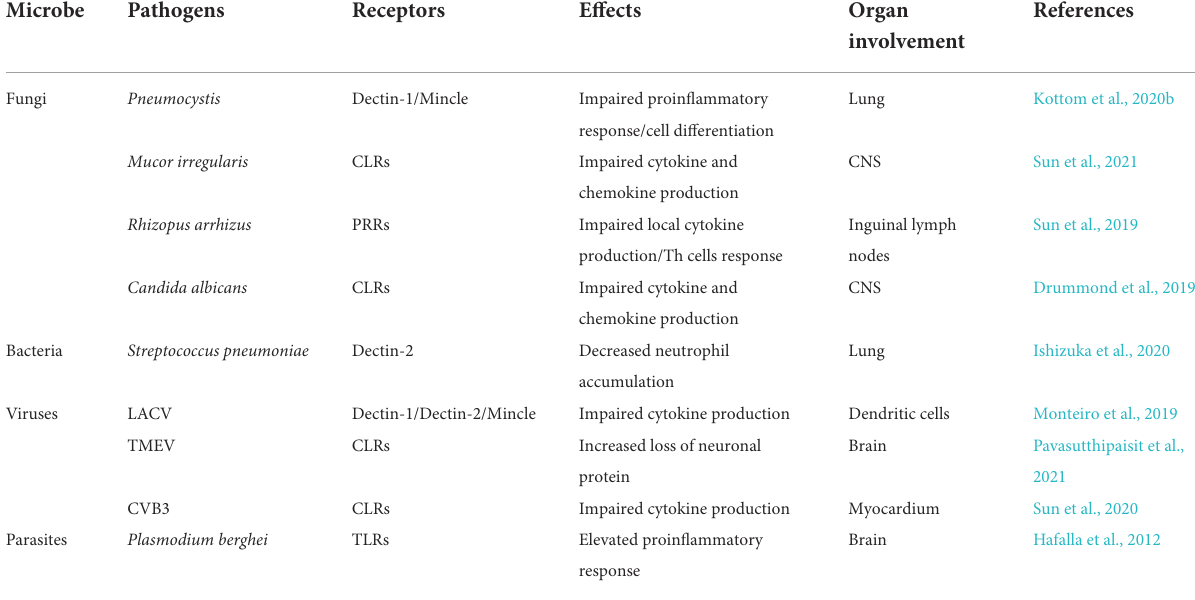
TABLE 2 Effects of CARD9-deficient mice on microbial